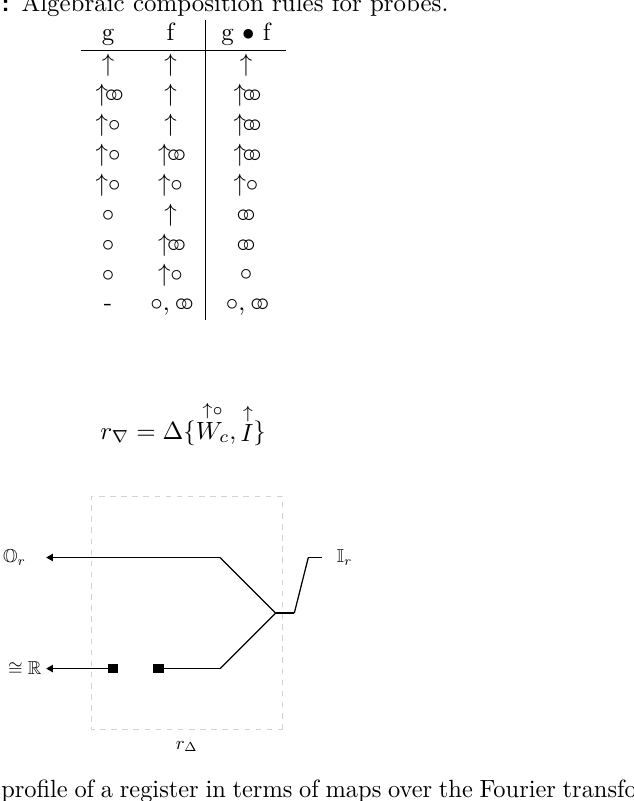
Table 1: Algebraic composition rules for probes.